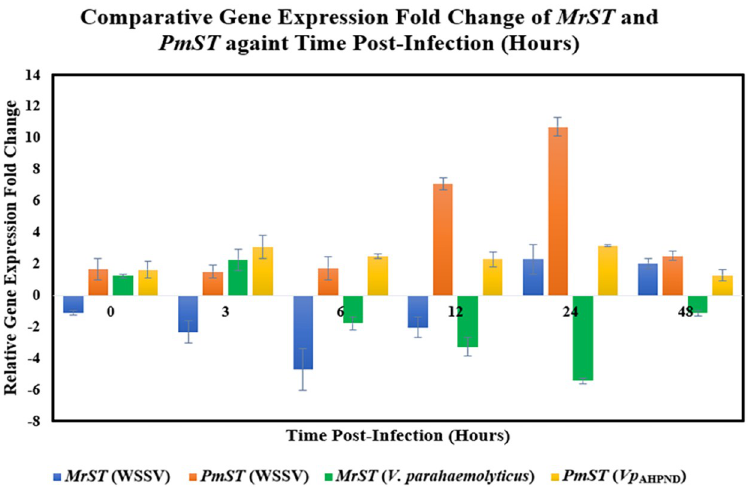
Fig 1. Comparative gene expression fold change of MrST and PmST against time post-infection (hours) (WSSV and V . parahaemolyticus / Vp AHPND ). All relative gene expression fold changes were statistically significant (P < 0.05). The error bars indicated standard deviations of the data. [ MrST (WSSV) Fold changes: 0 hpi: -1.113; 3 hpi: -2.332; 6 hpi: -4.699; 12 hpi: -2.038; 24 hpi: 2.287; 48 hpi: 2.017]. [ PmST (WSSV) Fold changes: 0 hpi: 1.650; 3 hpi: 1.500; 6